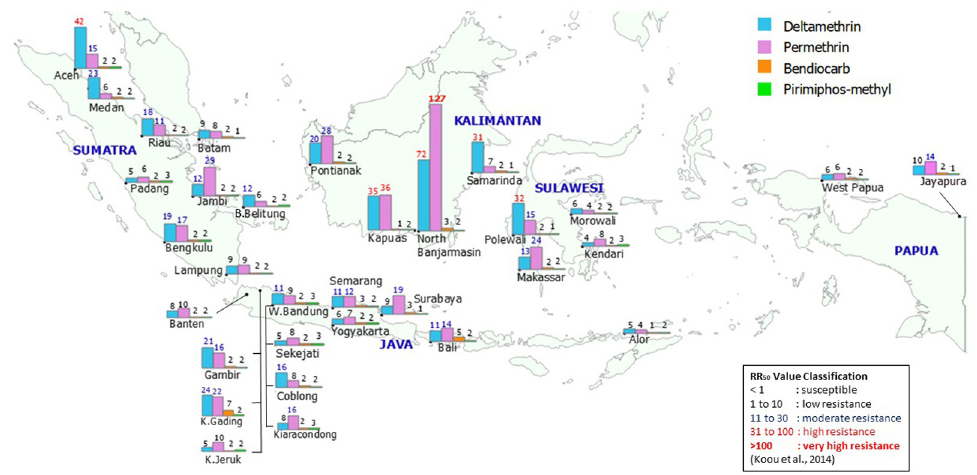
Fig 2. Map of susceptibility of Ae . aegypti field strains to tested insecticides. Map base layer was obtained from https:// www.naturalearthdata.com/. Map base layer was modified in QGIS software version 3.4 Madeira. Note: The number above each bar represents RR 50 , which was calculated relative to the susceptible reference strain (Bora-Bora).